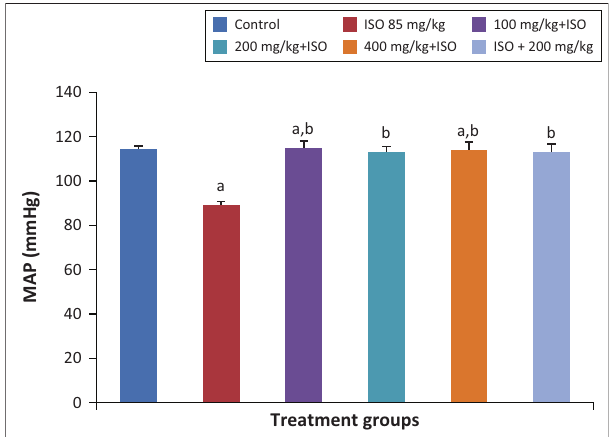
FIGURE 4: Effect of the ethanolic extract of Andrographis paniculata on superoxide dismutase enzyme in isoproterenol-induced myocardial infarction using rats as a model ( n =